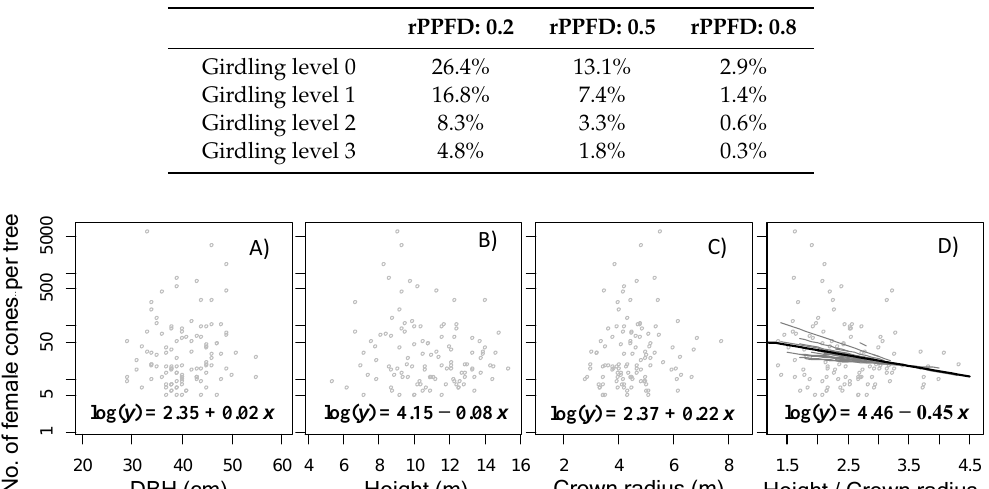
Table 2. The coe ffi cient of variance (CV) for among-clone di ff erences in the probability of producing female cones.